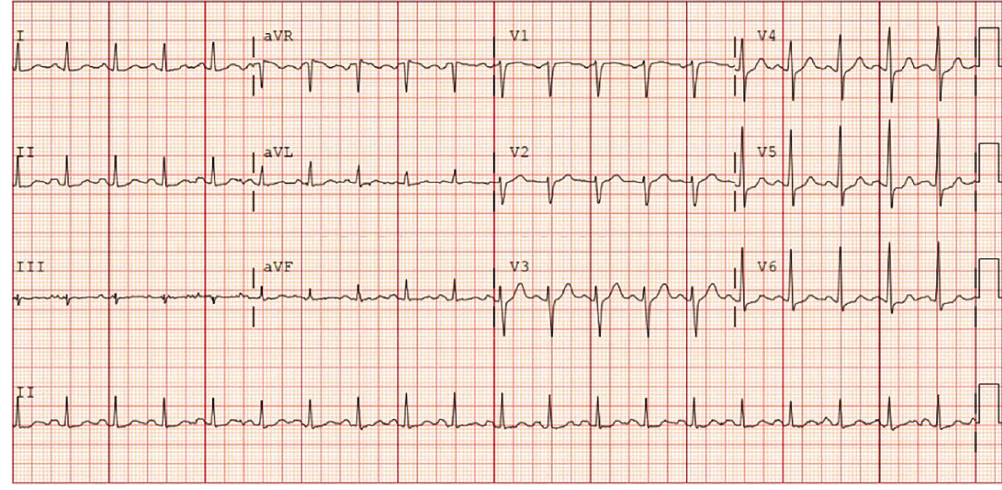
Figure 2: EKG on admission shows sinus tachycardia otherwise normal rhythm with no signi fi cant ST changes.